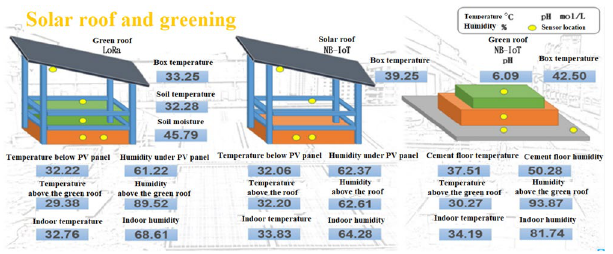
Figure 13. Integrated monitoring management page of the Advantech WebAccess